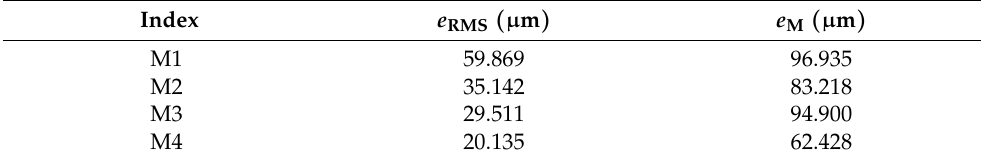
Table 4. Tracking performance of the MLRT for circular